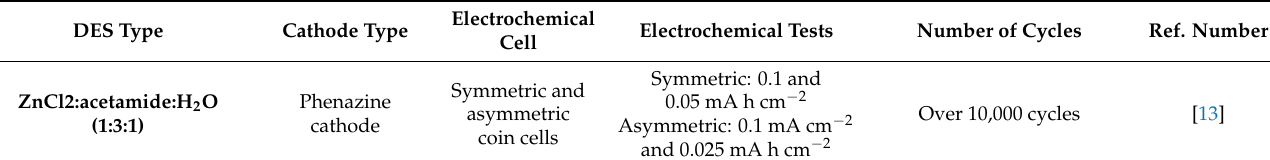
Table 1. Recent studies on DESs as rechargeable Zn battery